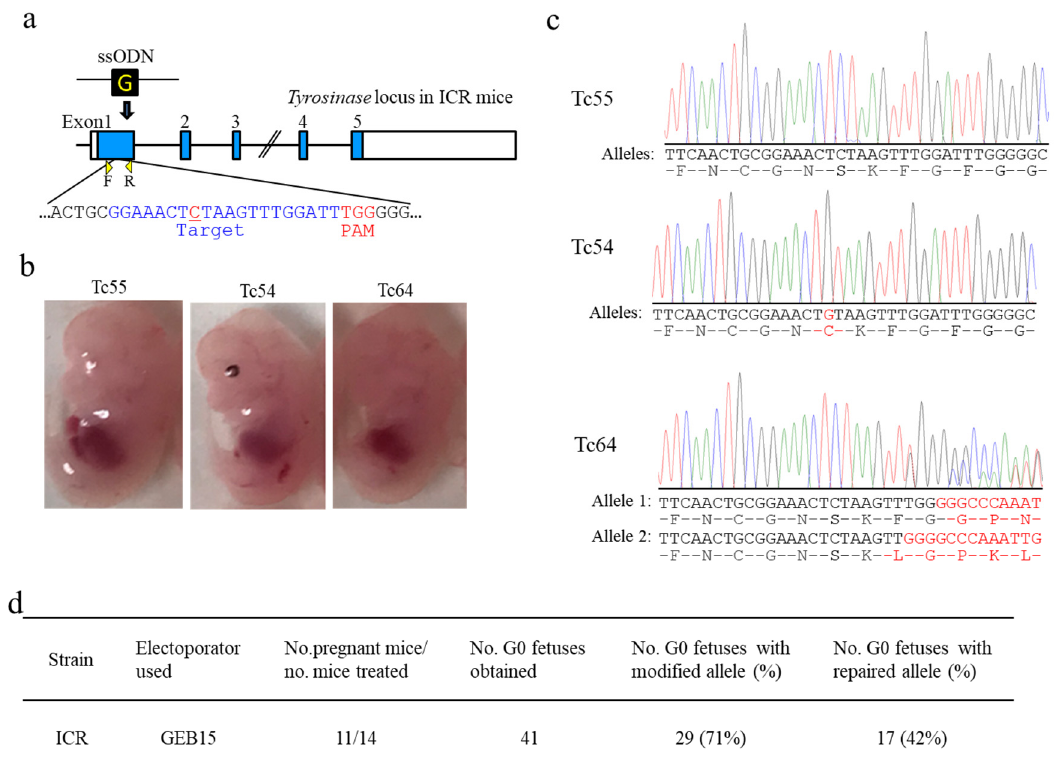
Figure 4 . i -GONAD-based KI of a wild-type sequence into the tyrosinase gene ( Tyr ) in Institute of Cancer Research (ICR) ice using GEB15 electroporator under the electric conditions of PdV 60 V, 250–400 Ω , and 130–335 mA. ( a ) Gene structure of Tyr in ICR mice, which is basically the same as shown in Figure 3a. ( b ) Mid-gestational fetuses (Tc55, Tc54, and Tc64) obtained from i -GONAD-treated plug-positive ICR females. ( c ) Direct sequencing of PCR products derived from the fetuses shown in (b). The Tc55 fetus showing depigmented eyes had mutated alleles. The Tc54 fetus showing pigmented eyes is judged as homozygous bi-allelic KI because both alleles had wild-type nucleotide “G” (shown by red), a key nucleotide for tyrosinase activity. The Tc64 fetus showing depigmented eyes is judged as heterozygous bi-allelic KO, each yielding different frameshifts of amino acids (shown by red). ( d ) Genome editing efficiency of the Tyr locus at ICR strain .